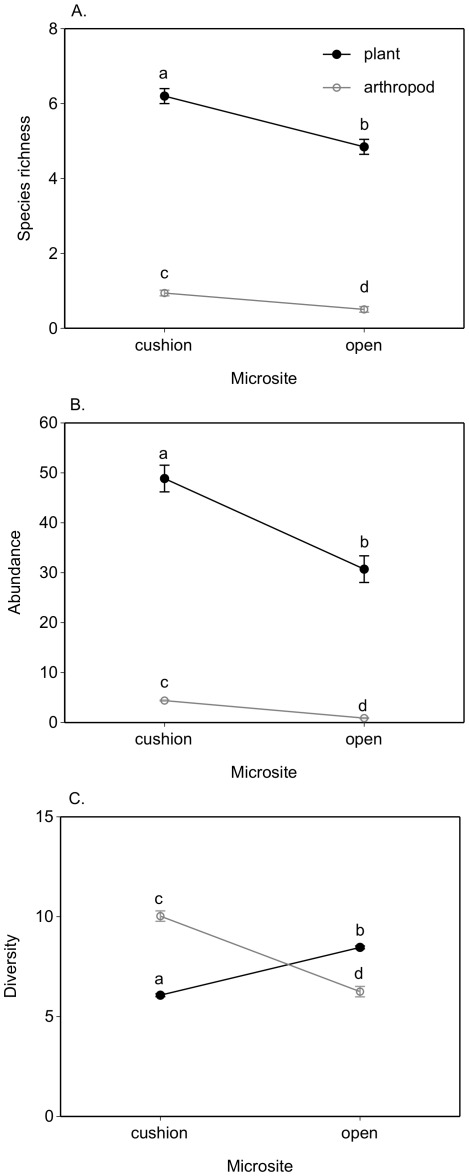
The mean community composition estimates for plants and arthropods associated with cushion plants and open non-cushion vegetated microsites.The mean +/−1 s.e. are denoted (significant Tukey post hoc contrasts denoted by different letters). Please see text for full details of response variables.